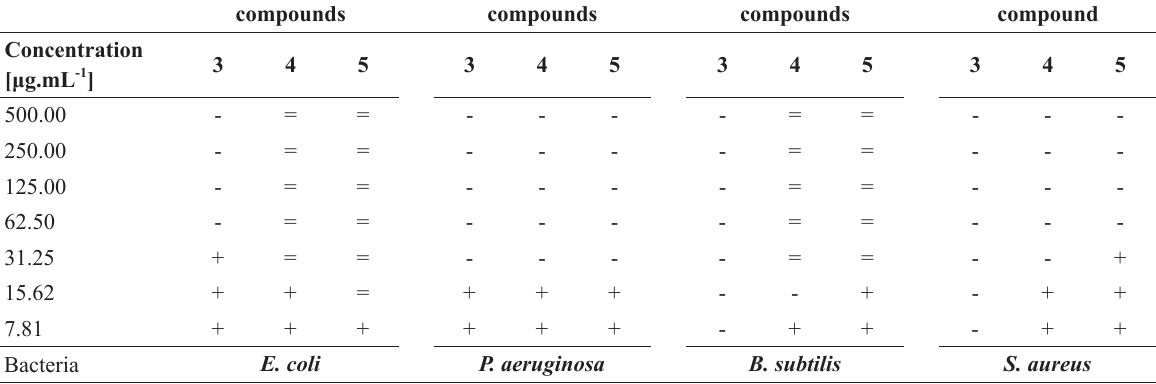
Bacteria E. coli = bactericidal effect, - bacteriostatic effect, + no